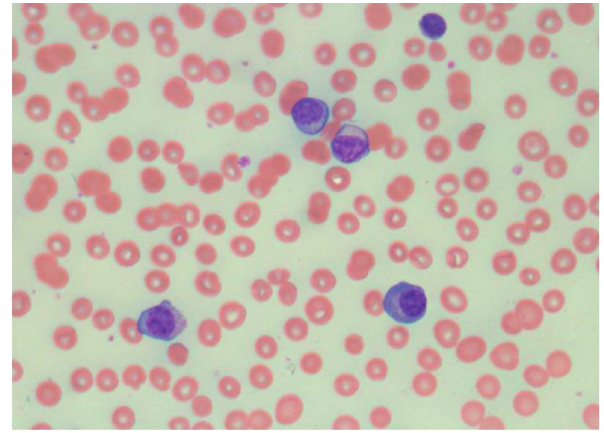
Figure 4: Circulating plasma cells in peripheral blood